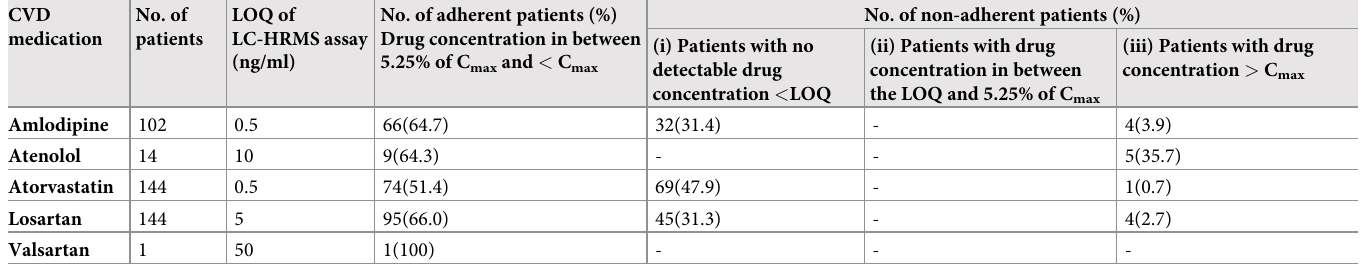
Table 4. Adherence and non-adherence amongst the Kenyan CVD patient cohort assessed using quantitative dried blood spot analysis of patient samples by LC-HRMS. CVD